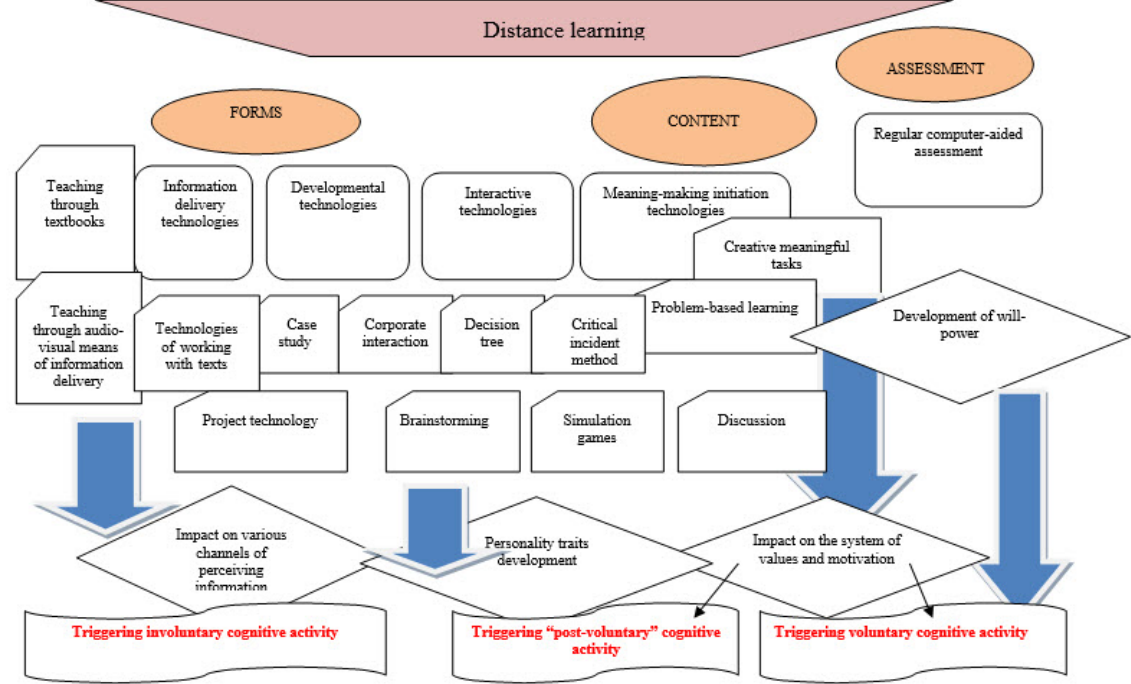
Figure 1. A chart outlining cognitive independence initiation in distance